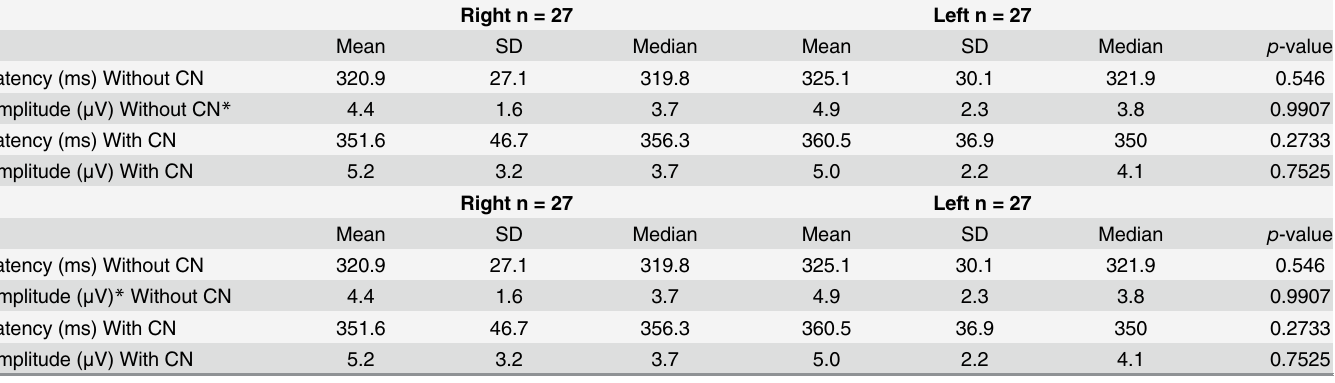
Table 1 displays the descriptive statistics of P300 latency and amplitude values with and with- out contralateral noise stimulation (CN) for the right and left ears. There was no statistically significant difference between ears for any of the studied measures (latency and amplitude) at any of the testing conditions (with and whitout noise). Therefore, the data obtained for each ear was combined on the next analysis [n = 54 ears (female n = 42 ears; male = 12 ears)]. Table 1. Comparison between the right and left ears for P300 latency (ms) and amplitude ( μ V) values in both assessment conditions: with and with- out contralateral noise (CN) stimulation. Right n = 27 Left n = 27 Mean SD Median Mean SD Median p